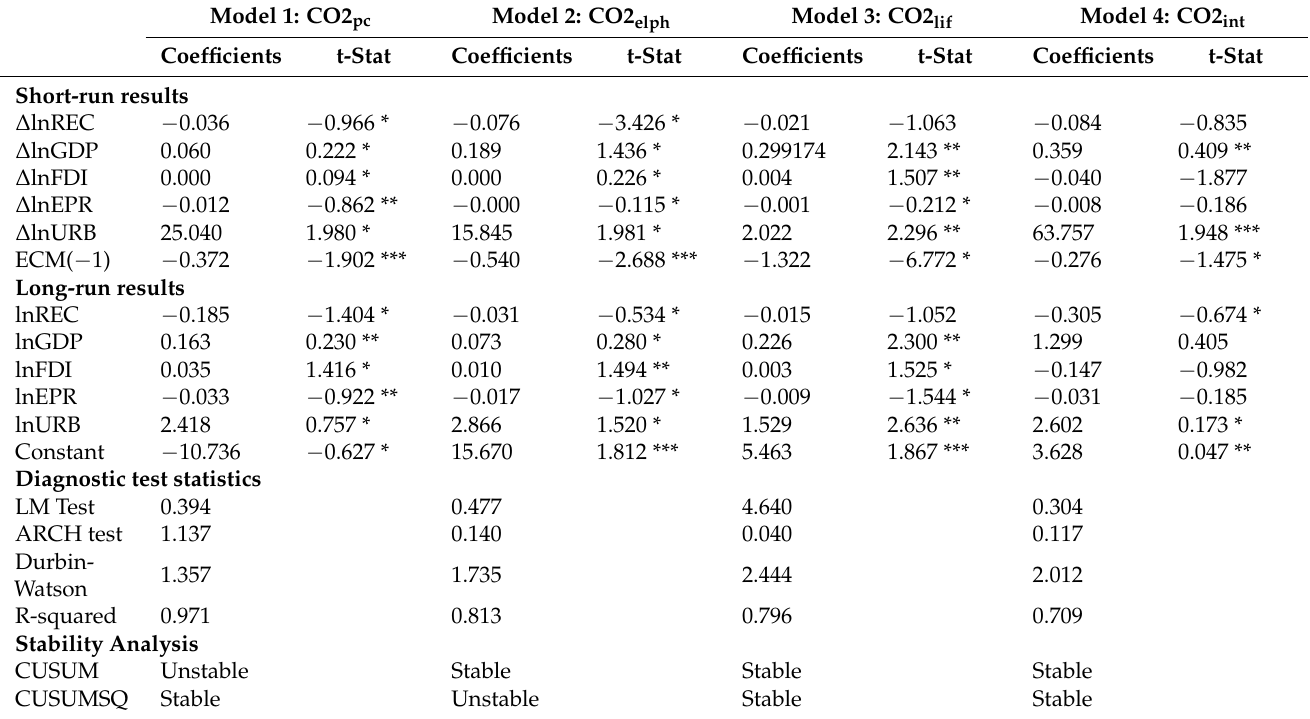
Table 6. Estimated coefficients from the ARDL